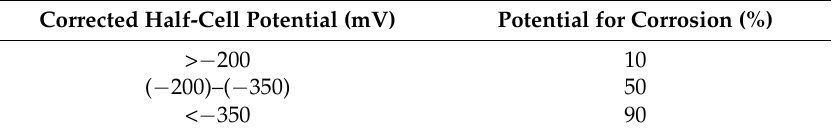
Figure 2. Mapping corrosion potential across the surface of a sample, ( a ) control, ( b ) thermal energy storage aggregate (TESA), and ( c ) TESA-nano-titanium (NT). Table 1. Potential corrosion in reference to half-cell potential ASTM C876-09